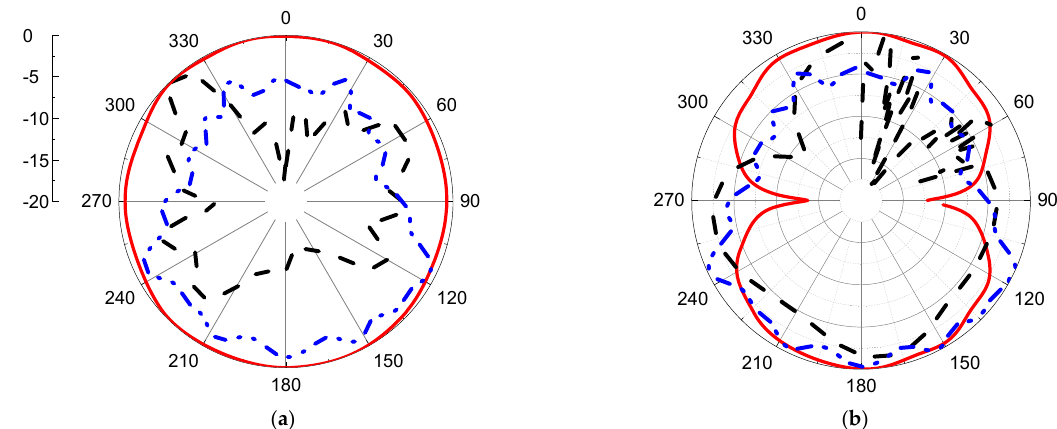
Figure 17. Radiation pattern for proposed antenna with and without breast model ( a ) ϕ = 0 ◦ , ( b ) ϕ = 90 ◦ Red line: simulated without phantom, black dash line: simulated with phantom, and blue dash ‐ dot line: measured without phantom) at 4.5 GHz.